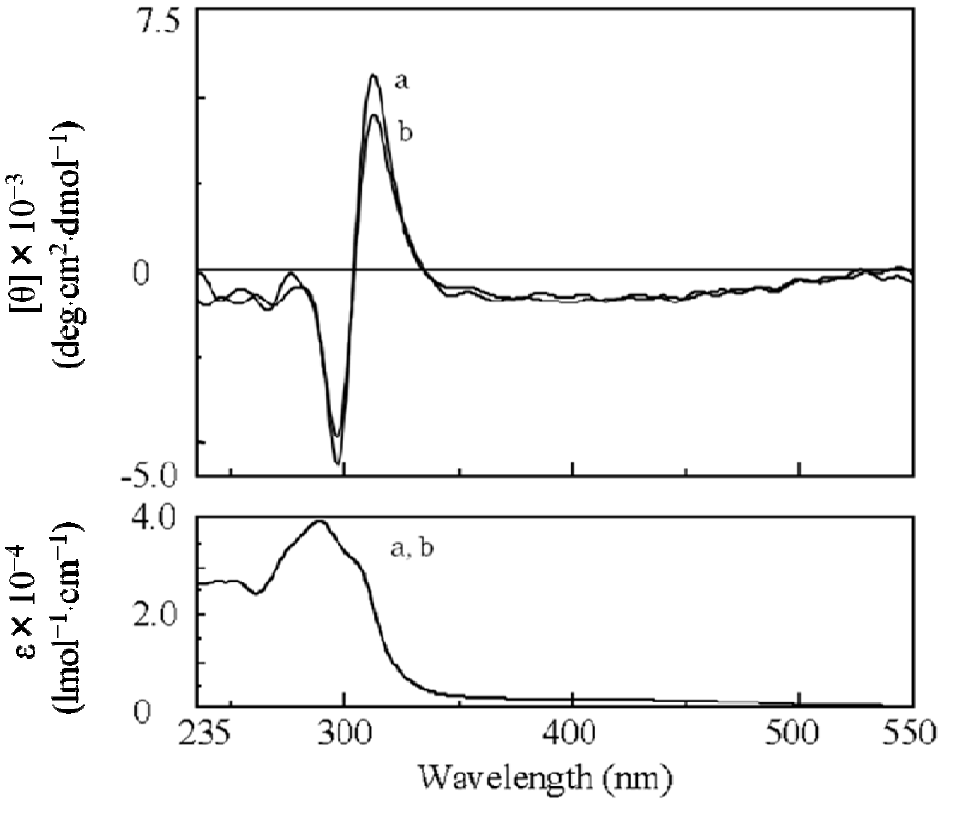
Figure 2. CD and UV-Vis spectra of poly( 1 ) at (a) 25 °C and (b) 60 °C in THF.